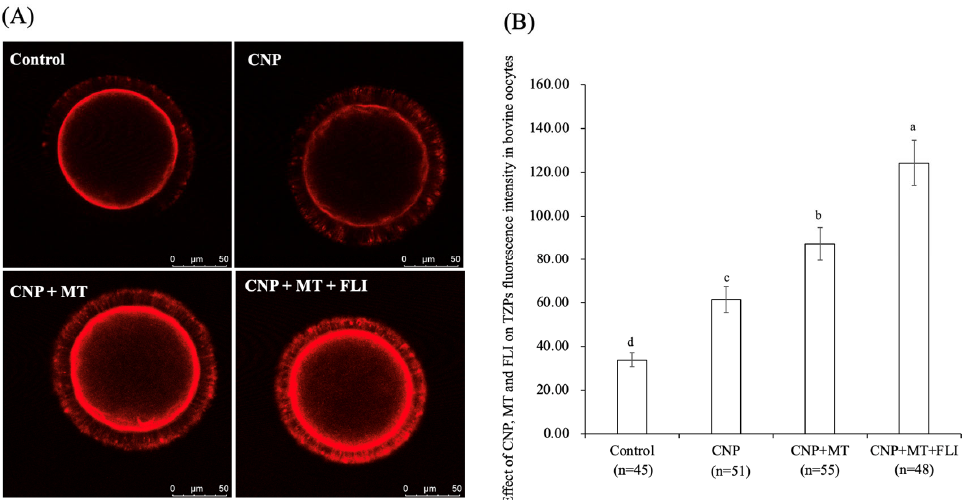
Figure 3. Effect of the combination treatment CNP, MT, and FLI on TZPs fluorescence intensity in bovine oocytes. ( A ) Representative image of TZPs staining in bovine oocytes. ( B ) Effect of the combination treatment of CNP + MT + FLI on TZPs in bovine oocytes. Bar = 50 µm. a, b, c, d Values with different superscripts indicate significant differences between groups ( p < 0.05).